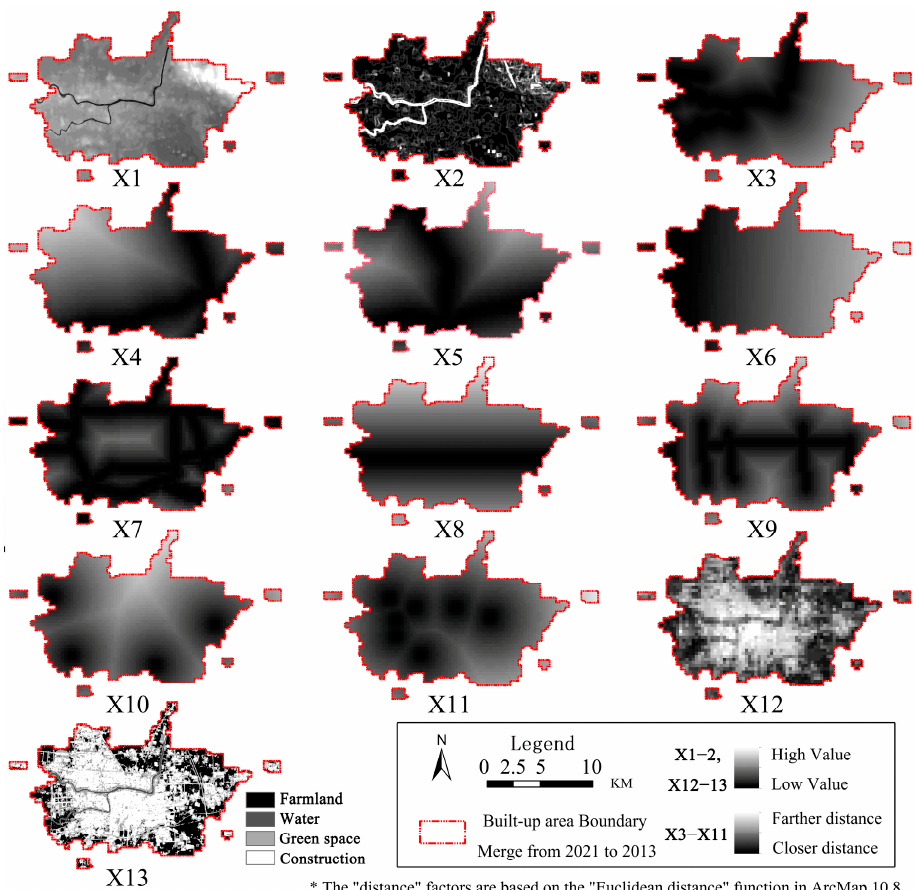
Figure 6. ( X1 ) DEM; ( X2 ) Relief; ( X3 ) River; ( X4 ) Expressways; ( X5 ) Railways; ( X6 ) High-speed railway; ( X7 ) National/provincial highways; ( X8 ) Road development axis; ( X9 ) General development axes; ( X10 ) Industrial cores; ( X11 ) Residential functional cores; ( X12 ) LUQ 2013 ; ( X13 ) Land use/land cover 2013.